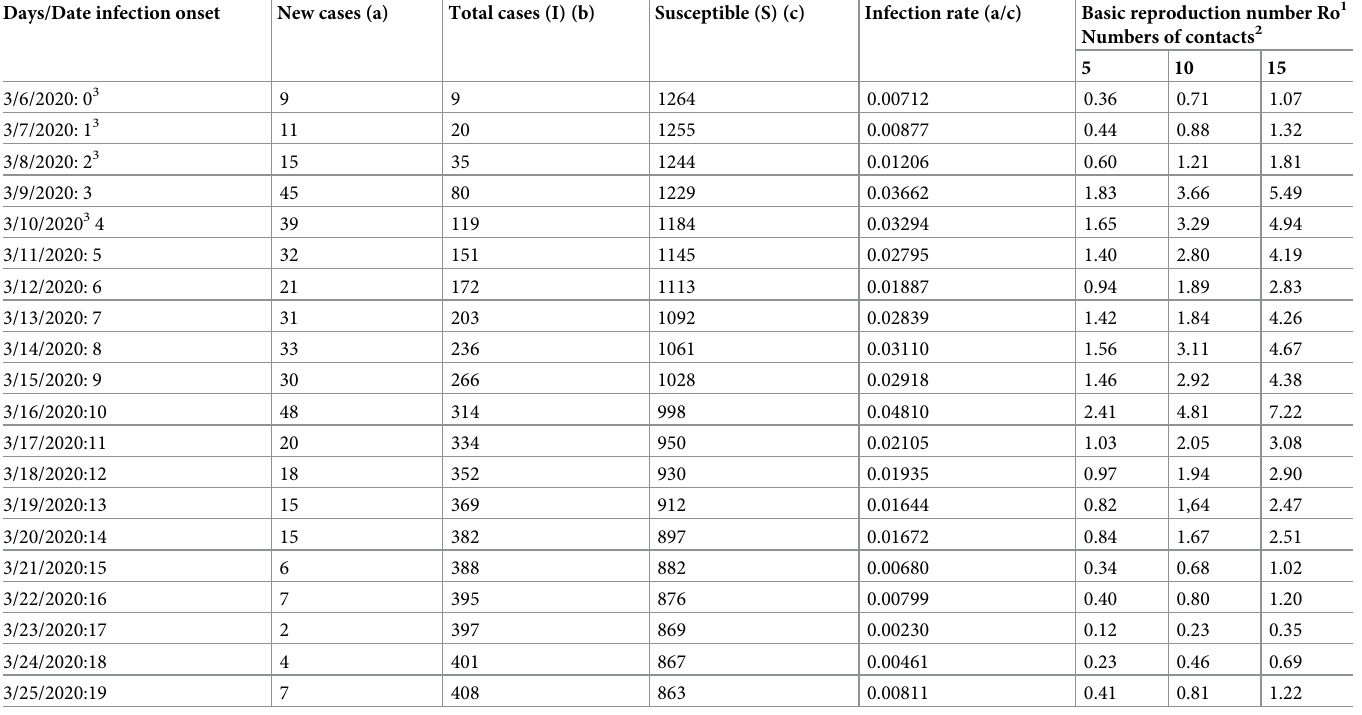
Table 9. Estimation of the basic reproductive number (Ro) from the MGE COVID-19 outbreak between 6 and 10 March 2020 plus 14 days. Days/Date infection